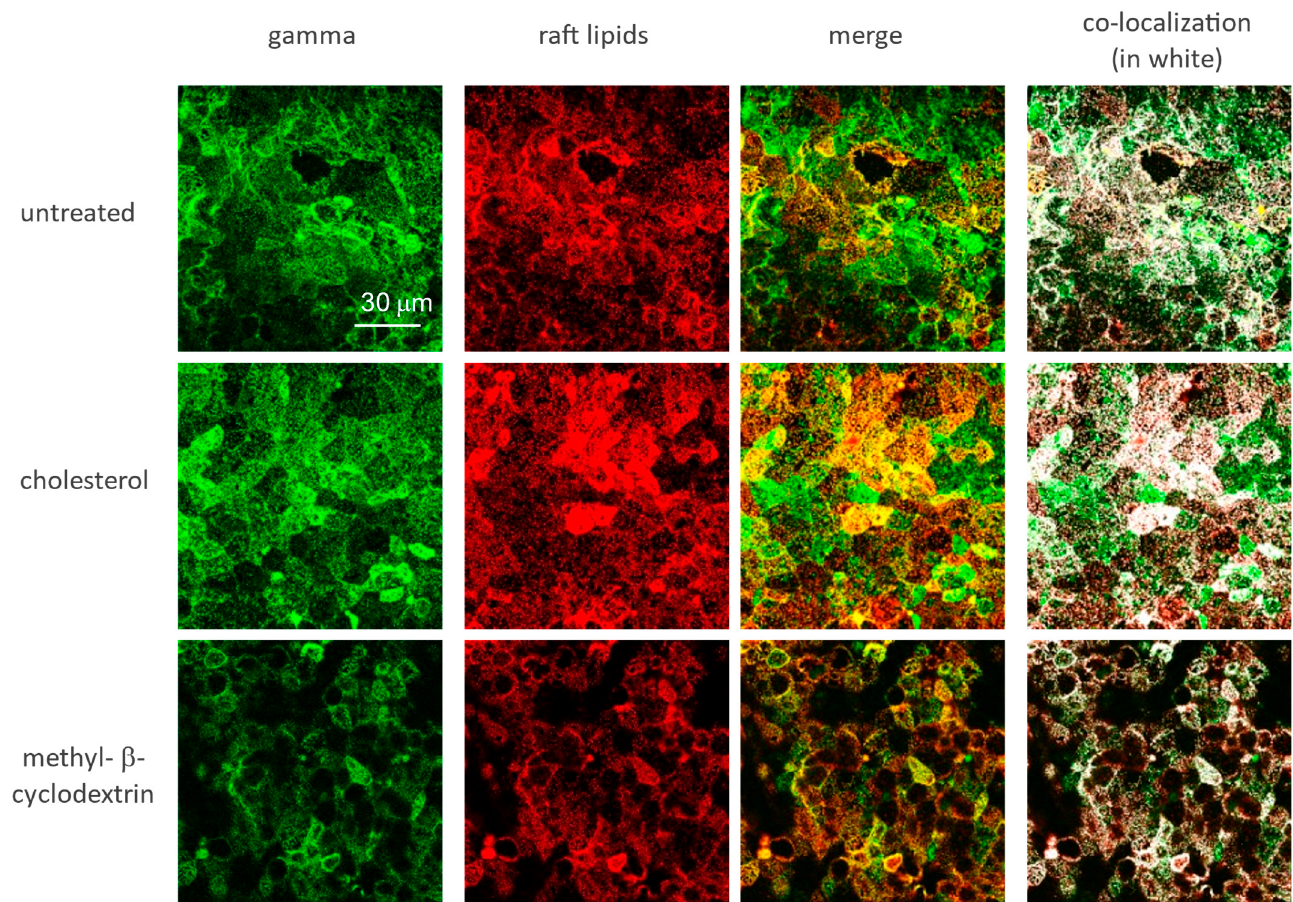
Figure 6. Raft lipids and γ -ENaC density are correlated with cholesterol in the membrane. We show images from confluent monolayers imaged with a water immersion 25× lens on an Olympus Fluoview confocal microscope (scale bar 30 μ m). Cells were either untreated, cholesterol treated (30 μ g/mL), or treated with methyl- β -cyclodextrin (M β CD) (20 mM). We measured the mean intensity and standard deviation of intensity of all pixels in each image and tested these for significant differ- ences. For γ -ENaC, the untreated and cholesterol-treated cell intensities are significantly different from the MbCD-treated cells ( p = 0.014 and <0.001, respectively). Untreated and cholesterol-treated intensities are not different ( p = 0.258). The same is true for the intensities of raft lipids: M β CD intensity is less than untreated and cholesterol-treated ( p = 0.005 and <0.001 for both), and untreated and cholesterol-treated are not different ( p = 0.385). For the merged images and the co-localization, the intensities of all images are significantly different from one another: untreated and cholesterol-treated vs. M β CD-treated at the p < 0.001 level and untreated intensity are less than cholesterol-treated ( p = 0.01 for merged and p = 0.025 for co-localization intensities). For the right panels, we used the “colocalization finder” plugin of “Image J” (8) to analyze our images for colocalization of the labels for CTX-B and γ -ENaC antibodies. This plugin allows the user to identify pixels that con- tain both channel 1 ( γ -ENaC fluorescence–green) and channel 2 (CTX-B fluorescence–red). These pixels are then highlighted in white. We restricted the analysis to pixels having ratios of intensity values in the two channels greater than 0.1.